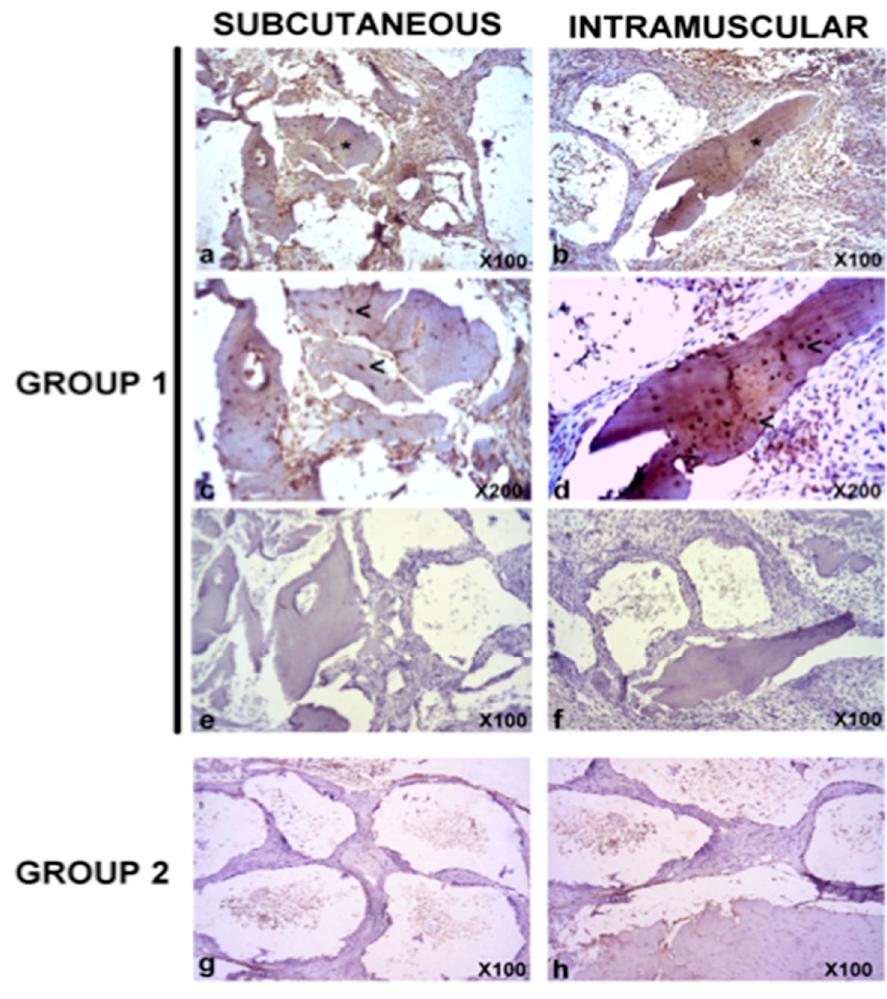
Figure 5. Representative images of human osteocalcin expression of subcutaneous and intramuscular constructs from Group 1 ( a – f ) and Group 2 ( g , h ) at week 9 after constructs implantation. There was positive expression of human osteocalcin in lamellar bone formations within subcutaneous or intramuscular constructs from Group 1 ( a , b asterisks), particularly in functional lacunae ( c , d , head arrows). Any sign of background was observed in negative controls of the same regions ( e , f ). On the other hand, no signs of positive immunoreaction were observed in subcutaneous and intramuscular constructs from Group 2 ( g , h ). ABC anti-human osteocalcin stain. Magnifications: 100 × ( a , b , e – h ) and 200 × ( c , d ). Table 2. Frequency of human osteocalcin expression in mice after construct implantation compared with the control. ** p < 0.01.